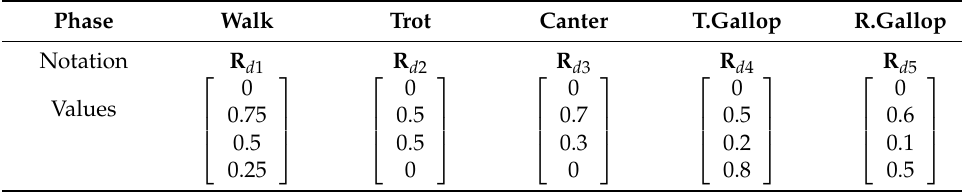
Table 2. Desired time-intervals, R di , according to gait phases. Phase Walk Trot Canter T.Gallop